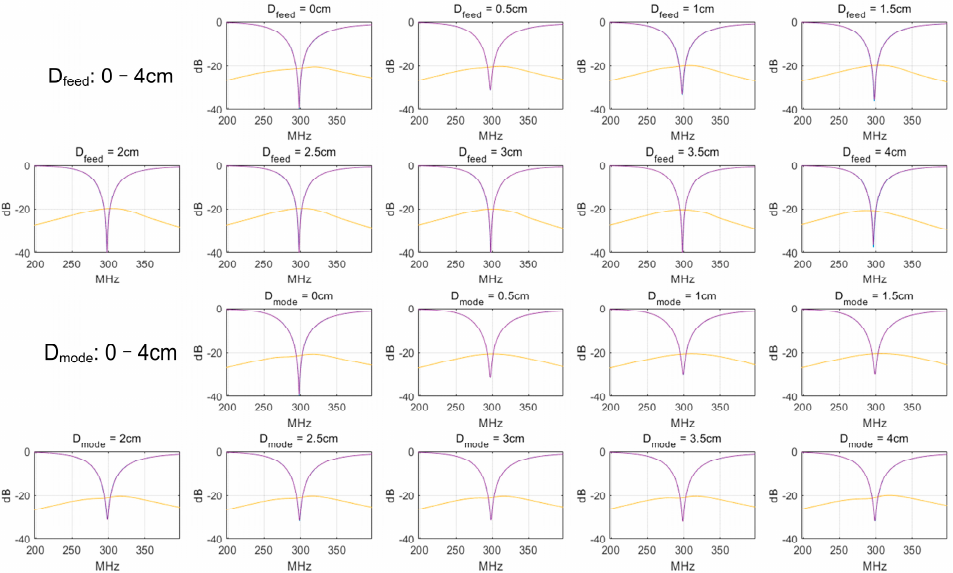
Figure 7. Simulated S-parameter plots of all pairs of self-decoupled coils with different D feed s and D mode s. For all scenarios, coils are well-tuned, matched, and decoupled, with S 11 /S 22 < − 30 dB and S 21 < − 20 dB.